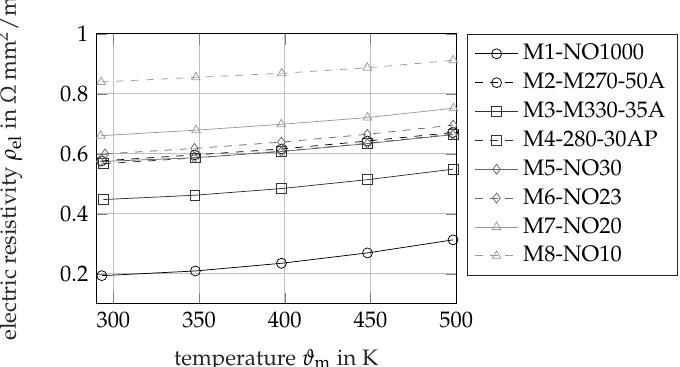
Figure 2. Results of the electric resistivity measurements ρ el ( ϑ ) .